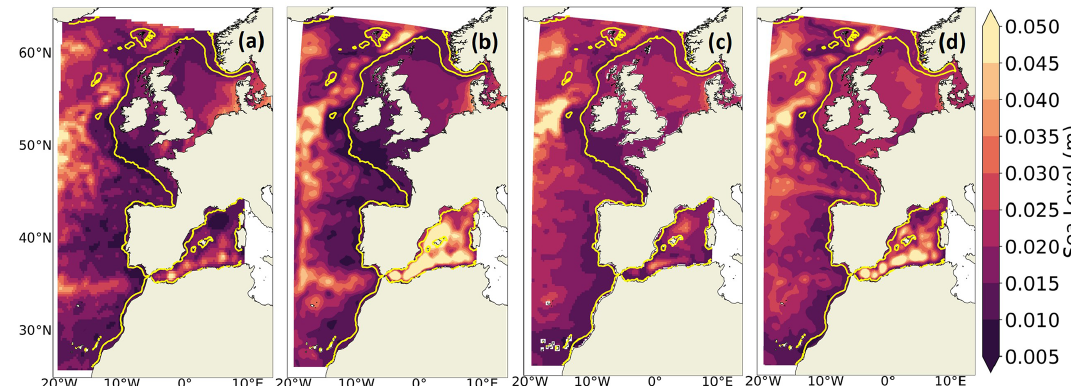
Figure 7. SL interannual variability over the 1993–2014 period in (a) altimetry, (b) IBI-ERAi, (c) CNRM-CM6-1-HR and (d) IBI-CCS_corr. The interannual variability is computed as the standard deviation of the detrended annual mean SL. Note that all panels here do not include the inverse barometer effect on sea level. The shelf break (defined by the 200m isobath) is indicated in yellow.